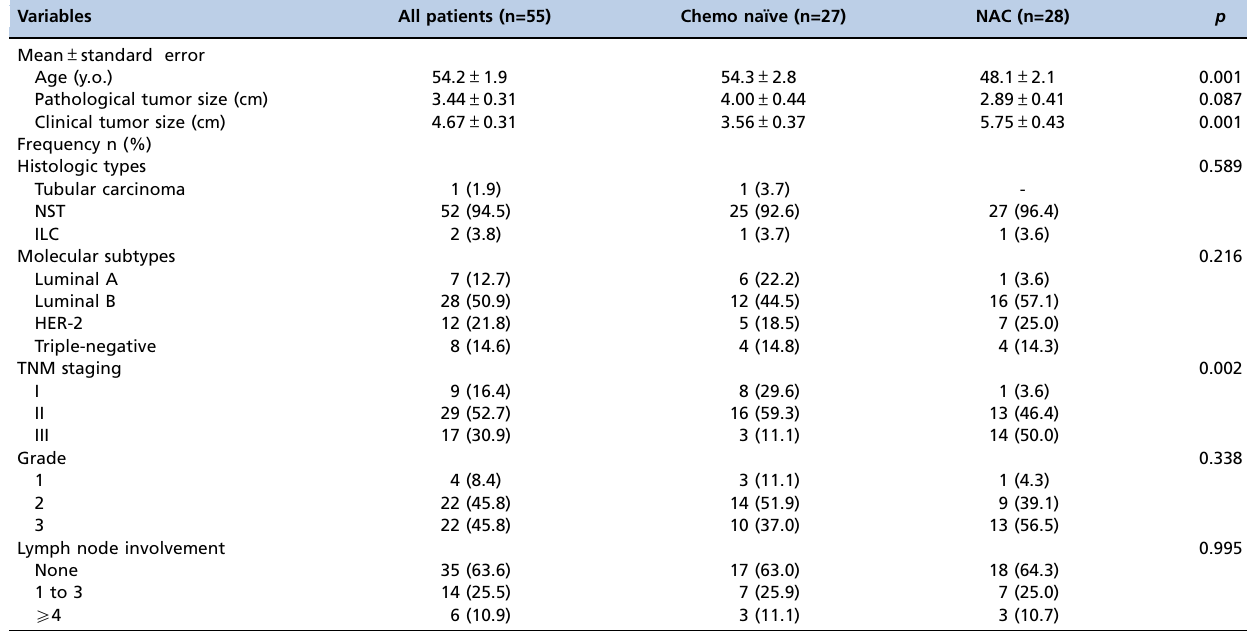
Table 1 - The clinical and pathological characteristics of the study participants. Variables All patients (n=55) Chemo naı¨ve (n=27) NAC (n=28) p Mean ± standard error Age